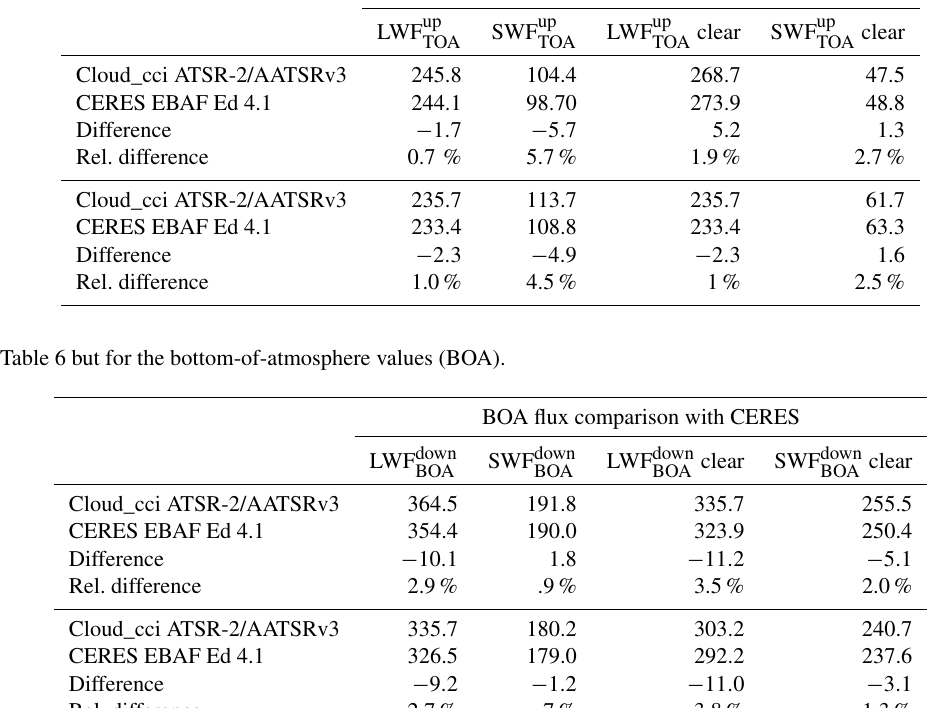
Table 6. Multi-annual (2003–2012) zonally averaged broadband shortwave and longwave fluxes (SWF, LWF) at the top-of-atmosphere (TOA) inferred from the Cloud_cci AATSR V3 data set. Two latitude ranges, − 60 to 60 ◦ (top) and − 90 to 90 ◦ (bottom), are presented. The values are compared with the equivalent values from the Clouds and Earth Radiation Energy System (CERES) Energy Balanced and Filled (EBAF) fluxes (all values are given in Wm − 2 ). The differences and relative differences are also reported. TOA flux comparison with CERES LWF up SWF up TOA TOA